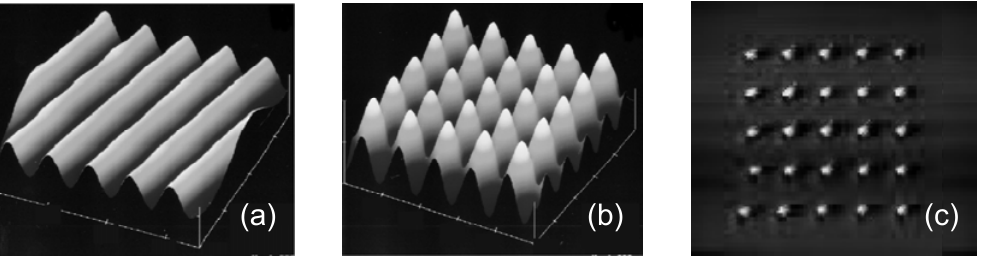
Figure 12. Typical example of PSRs formed by exposure of ( a ) an interference pattern with 0.6- μ m period; ( b ) orthogonal interference patterns with 1- μ m periods; and ( c ) optical near field emitted from an optical fiber with 30-nm